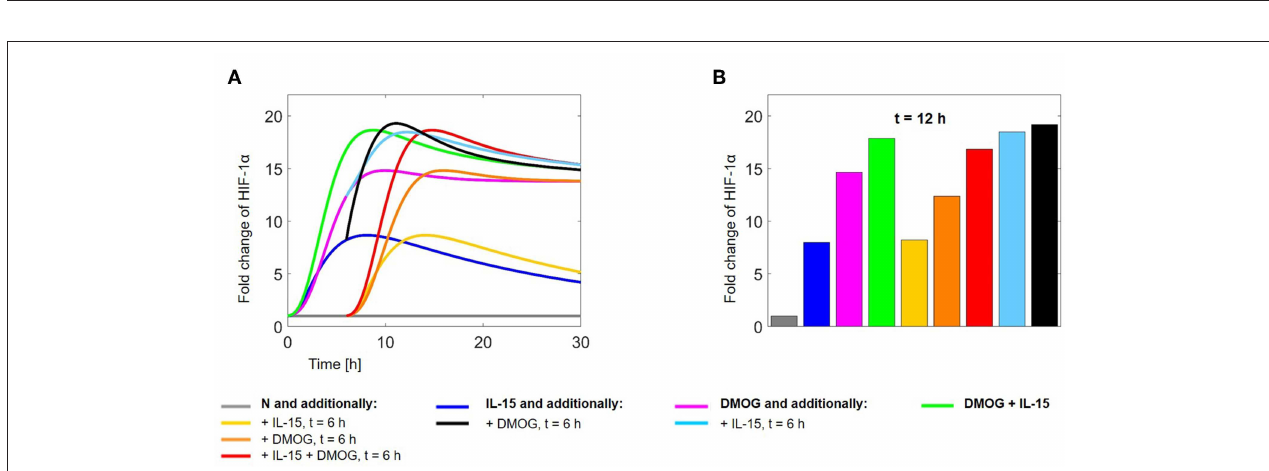
FIGURE 12 | (A) HIF-1 α evolution in time and (B) fold change at t = 12 h, normalized with respect to HIF-1 α levels in untreated cells. Colors correspond to the following experimental settings: (gray) untreated cells (N) for 30 h; (dark blue) IL-15 stimulation at time t = 0 h; (magenta) cells in DMOG for 30 h; (green) cells in DMOG for 30 h with IL-15 stimulation at t = 0 h; (yellow) IL-15 stimulation at t = 6 h; (orange) DMOG treatment at t = 6 h; (red) IL-15 stimulation and DMOG treatment at t = 6 h; (light blue) DMOG treatment at t = 0 h and IL-15 stimulation at t = 6 h; (black) IL-15 stimulation at t = 0 h and DMOG treatment at t = 6 h.